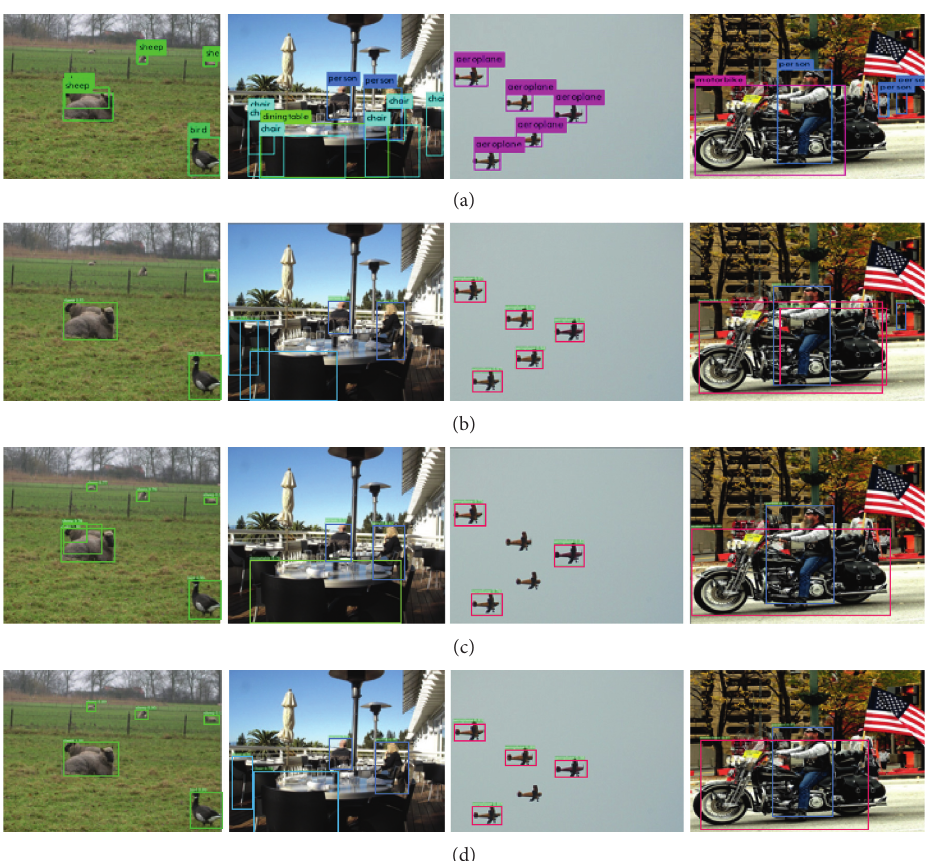
Figure 2: The visualization of detectors with the strongest backbones on subsets of PASCAL, VOC_MRA_0.58, VOC_MRA_10, VOC_MRA_20, and VOC_WH_20 in order, respectively: (a) YOLO Darknet-53; (b) Faster RCNN ResNeXT-101-64 × 4d-FPN; (c) RetinaNet ResNeXT-101-64 × 4d-FPN; (d) Fast RCNN ResNeXT-101-64 ×